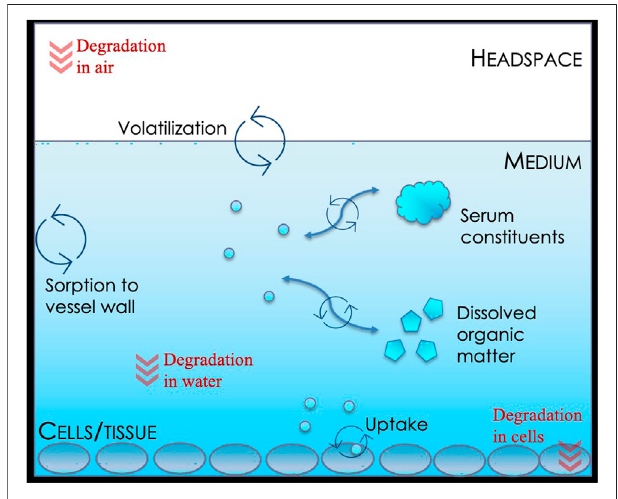
FIGURE1| Schematic representation ofthechemicalbiokinetics invitro environment as described by the IV-MBM DP v1.0 model.